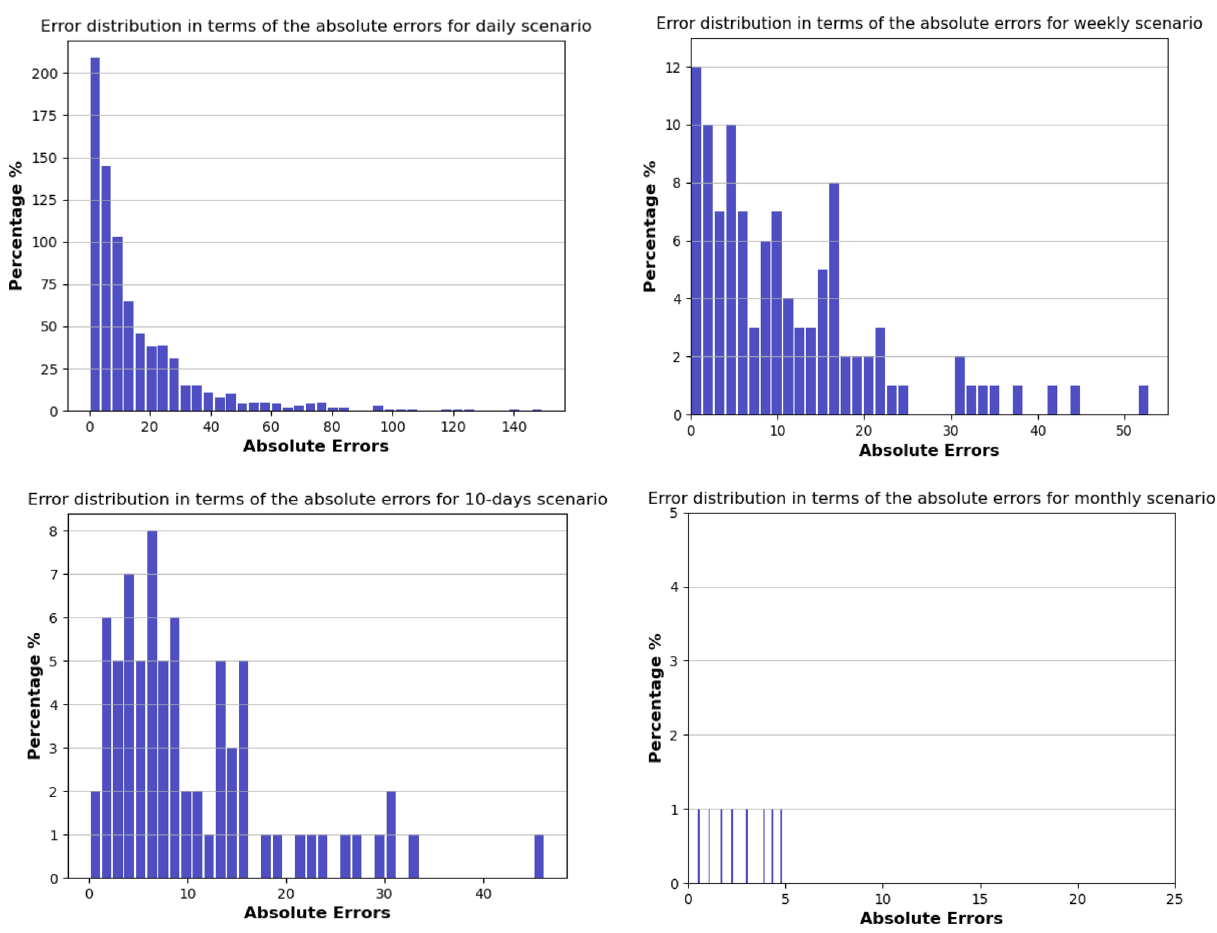
Figure 14. Error distribution in terms of the absolute errors (A.E.) for four scenarios: daily, weekly, 10-days, and